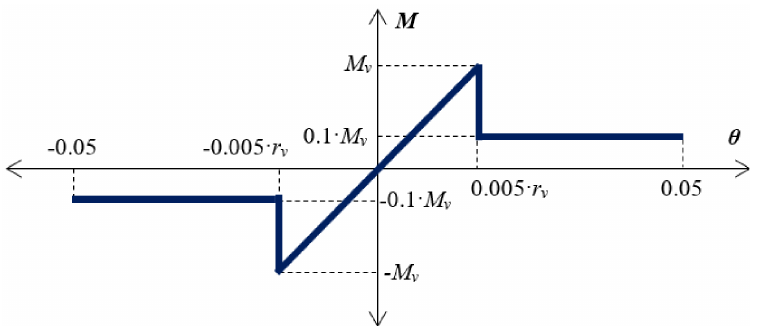
Figure 3. Moment–Rotation ( M – θ ) relationship used in simulating the response of R/C columns to shear failure in the web.